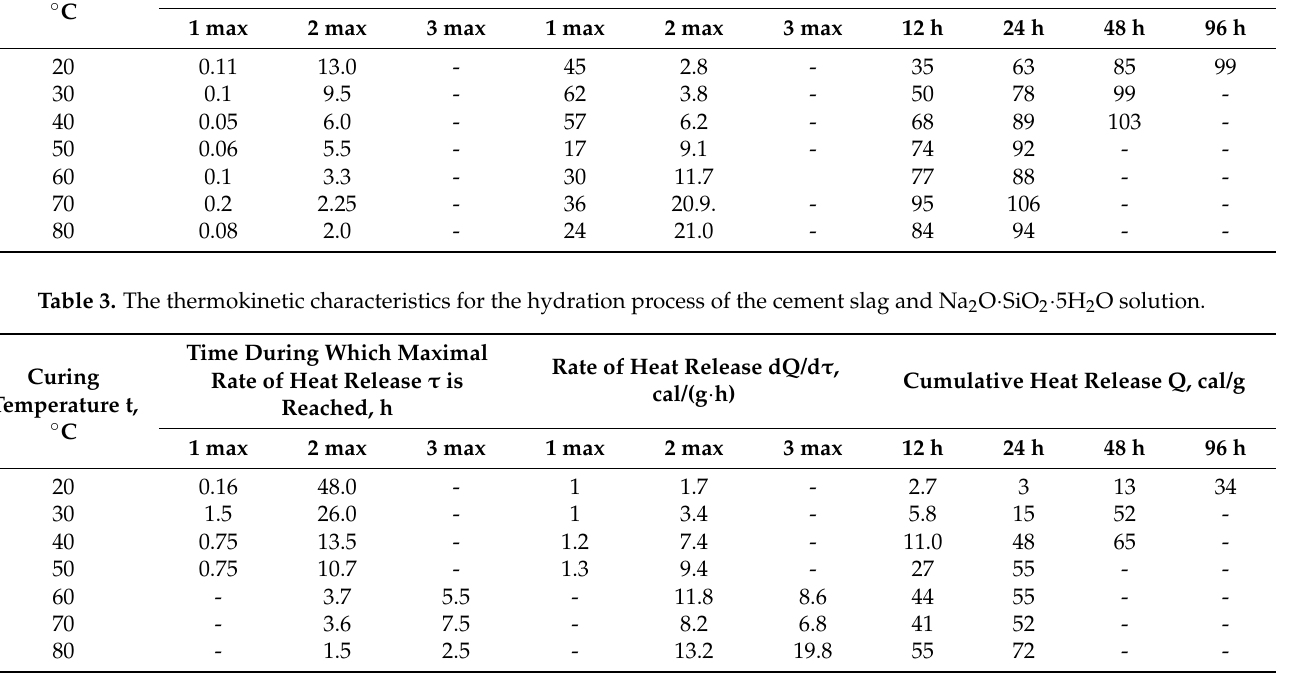
Table 2. The thermokinetic characteristics for the hydration process of clinker and H 2 O. Curing Temperature t, ◦ C